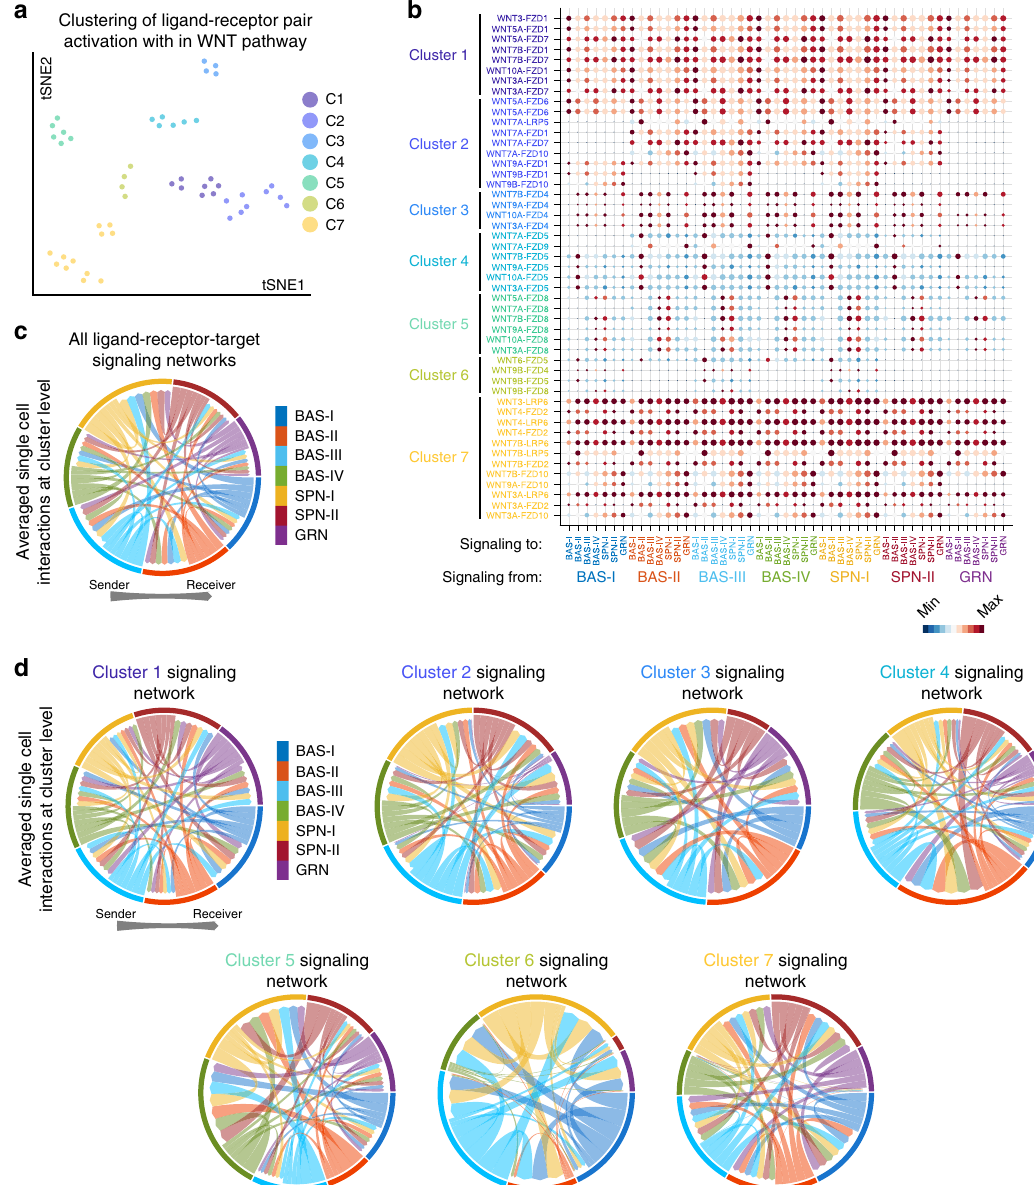
Fig. 3 Cell-cell interaction modeling of the WNT signaling pathway. a Hierarchical clustering of similar cell-cell signaling probability scores from library 3 and visualized on a tSNE plot. b Visualization of signaling probability scores of Ligand-Receptor pairs and their downstream signaling components. Dot size represents number of averaged cells with probability scores between clusters. c Cell-cell communication networks predicted for the entire WNT pathway or for ( d ) individual Cluster networks from B. Edge weights represent the probability of signaling between cell